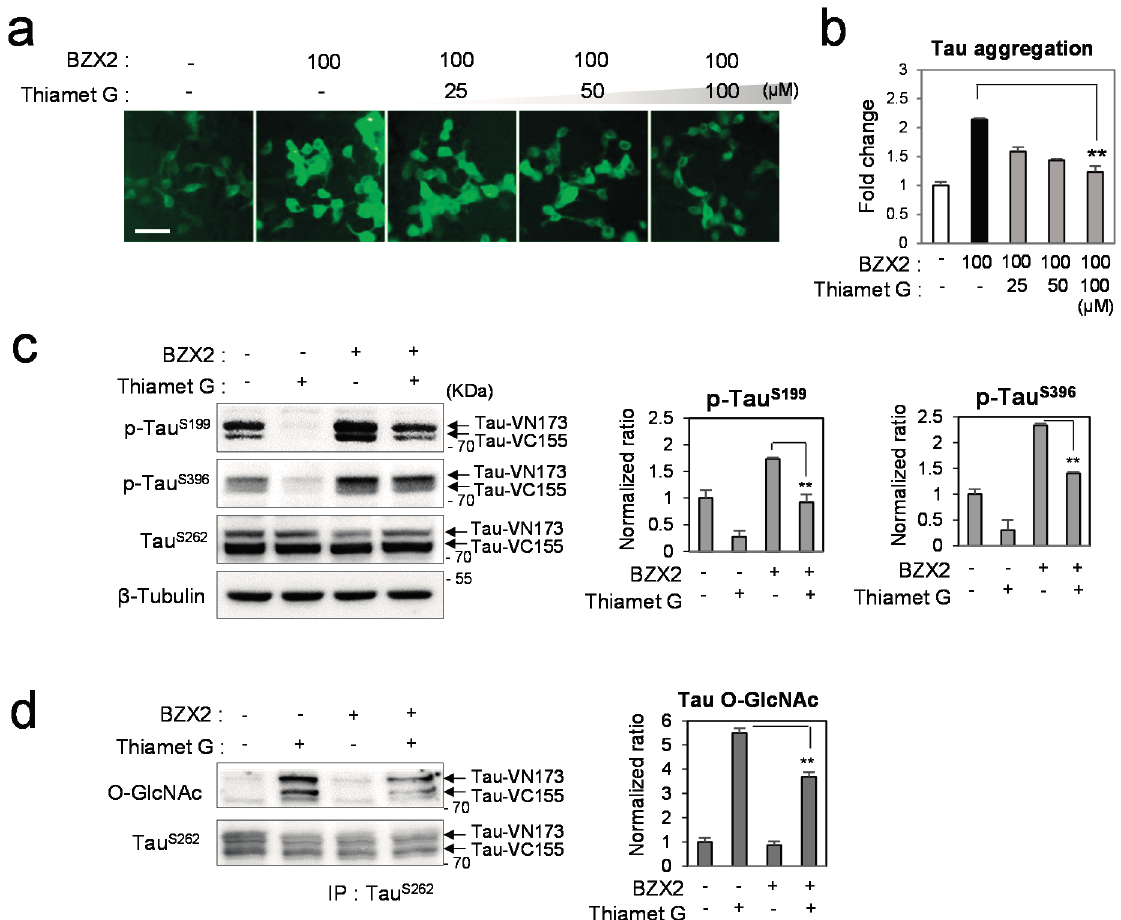
Figure 3. The opposite regulatory effect of OGA and OGT under co-treatment of OGA and OGT inhibitors. ( a , b ) Tau-BiFC cells were incubated with BZX2 (100 µM) or BZX2 co-treated with Thiamet G (25, 50 and 100 µM) for 24 h. Then, cellular responses of tau-BiFC fluorescence were imaged by using Operetta ® ( a ) and quantified by Harmony 3.1 software ( b ). Error bars represent the standard deviations from two independent experiments and each experiment was triplicated. The significance of the experiments was determined with paired t -test. ** p < 0.01. Scale bar = 50 µm; ( c ) Immunoblot analysis of tau phosphorylation and the quantification. For immune-blot analysis, tau-BiFC cells were incubated with Thiamet G (100 µM), BZX2 (100 µM) or Thiamet G co-treated with BZX2 for 24 h. The levels of tau phosphorylation were determined using anti-phospho-Ser199 or anti-phospho-Ser396 antibodies. Anti- β -tubulin antibody was used for loading control. The relative levels of tau phosphorylation were quantified and normalized with that of non-phosphorylated tau (TauSer262). Black arrows indicate two parts of tau-conjugated BiFC compartments (Tau-VN173 and Tau-VC155); and ( d ) Immunoblot analysis of tau O -GlcNAcylation levels on immuno-affinity purified tau and the quantification. The relative levels of tau O -GlcNAcylation were normalized with that of non-phosphorylated tau (TauSer262). Error bars represent standard deviation from three independent